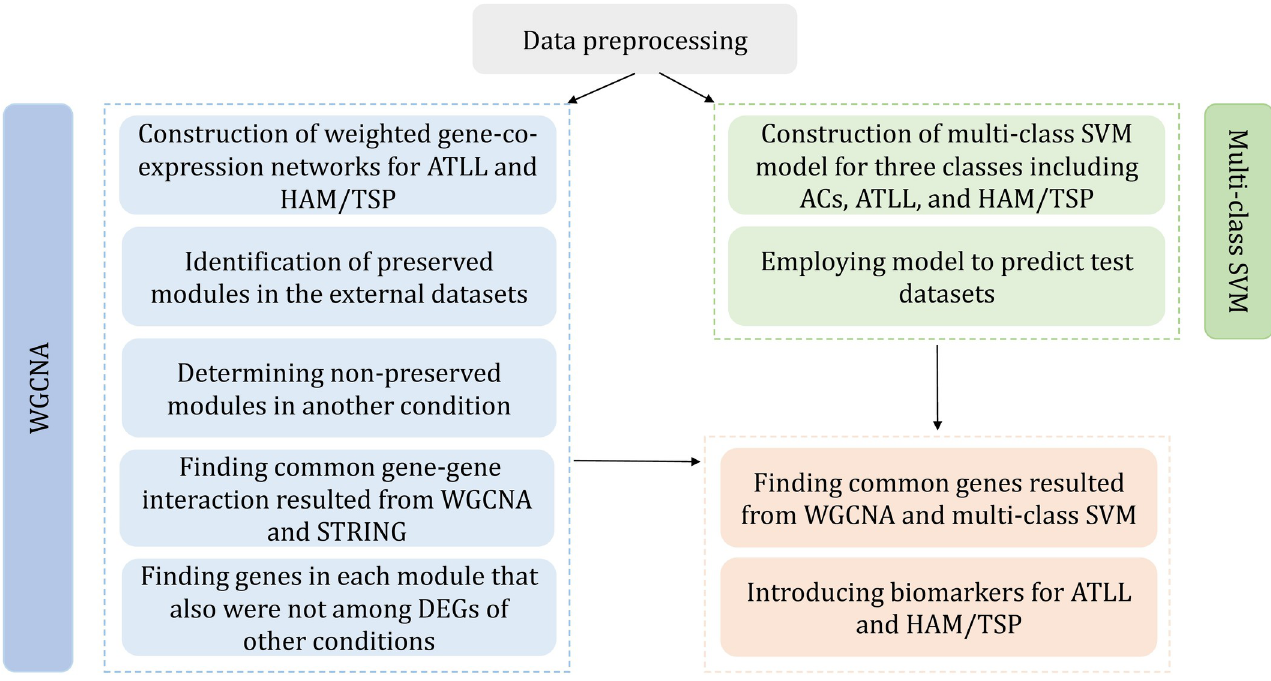
Fig 1. Workflow of the proposed